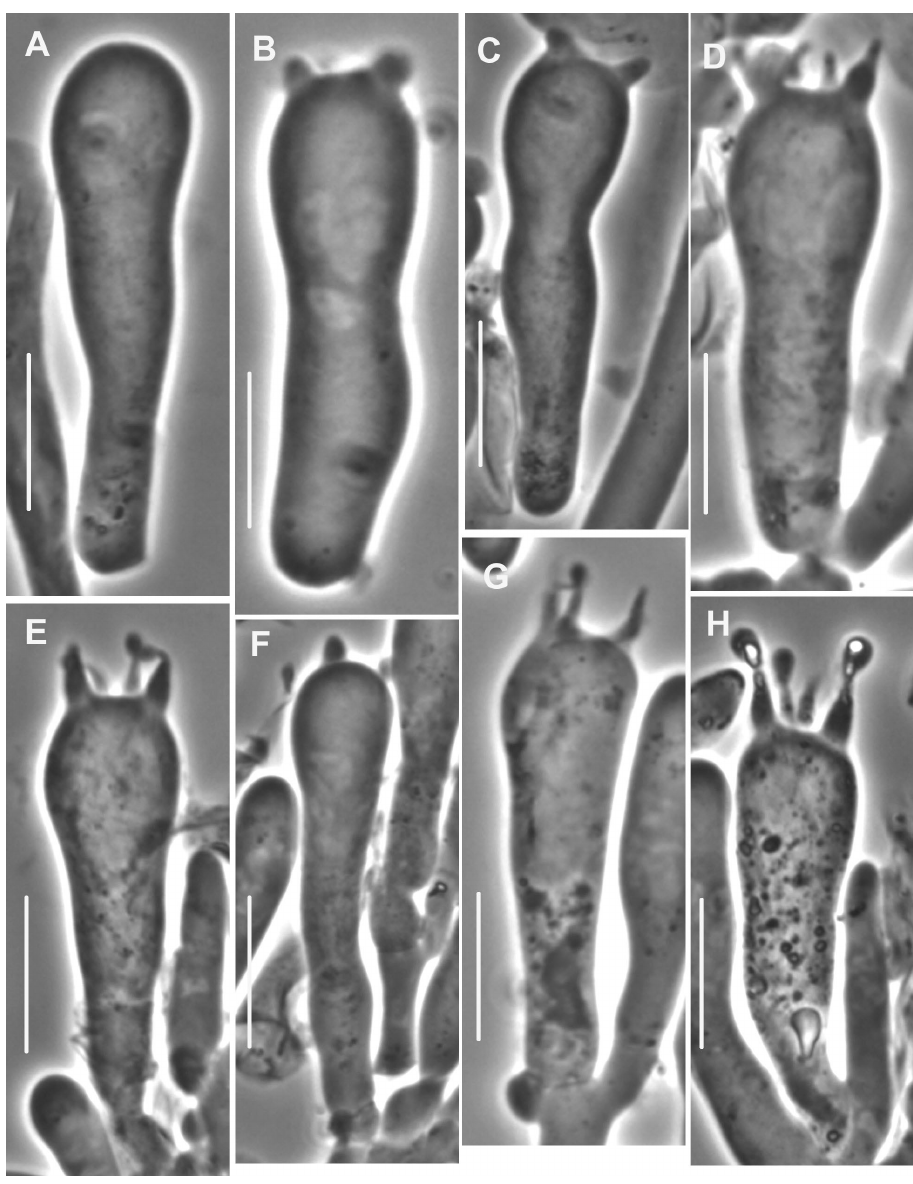
Figure 62. Mycetinis prasiosmus . Hymenial structures. A Basidiole B Immature basidium C Two- sterigmate basidium D–H Mature 4-sterigmate basidia. NOTE: Clam connection on G. Standard bars = 10 µm.